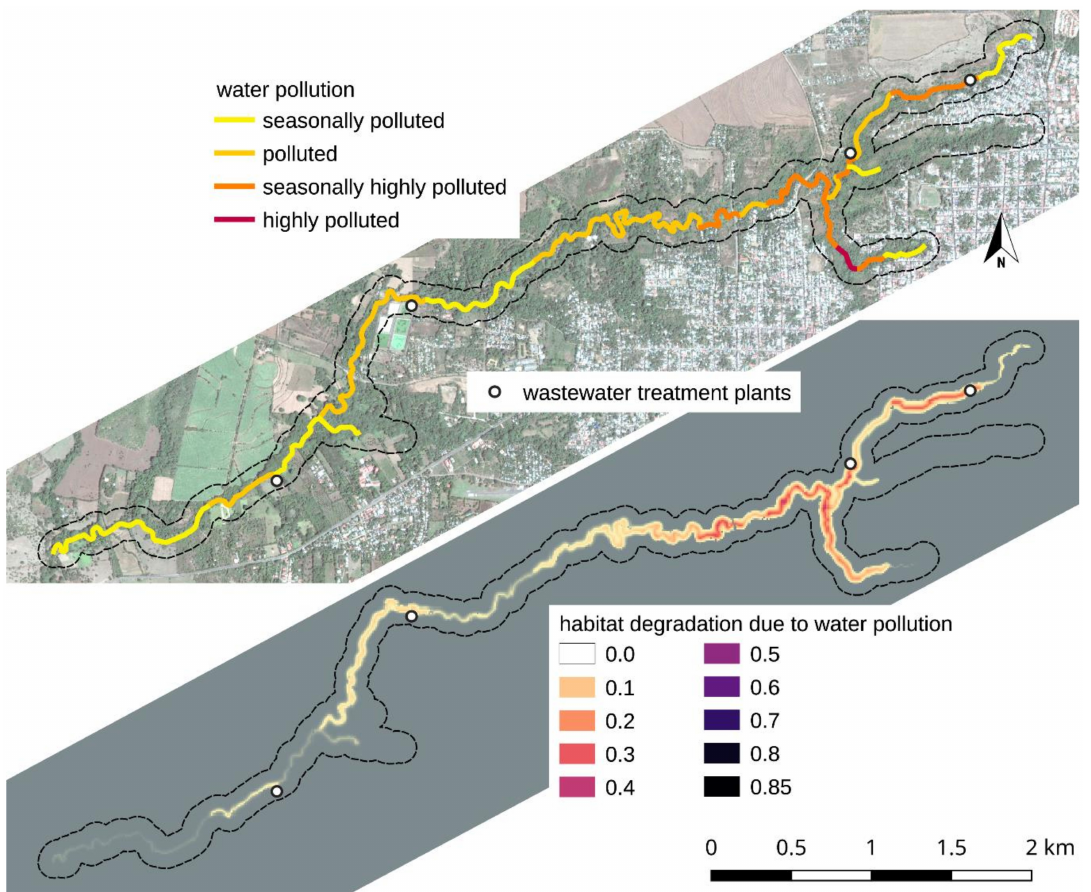
Figure 5. Spatial variation of water pollution (top) and habitat degradation due to di ff erent degrees of water pollution (bottom) in the study area. The grey shade in the bottom picture is used as a background to provide a better